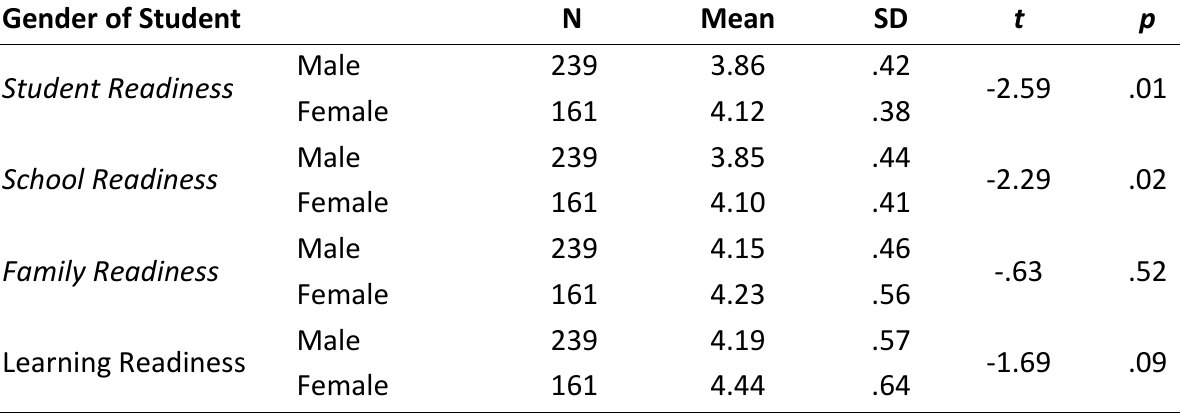
Table 3: Learning Readiness among School Students’ across their Sex Gender of